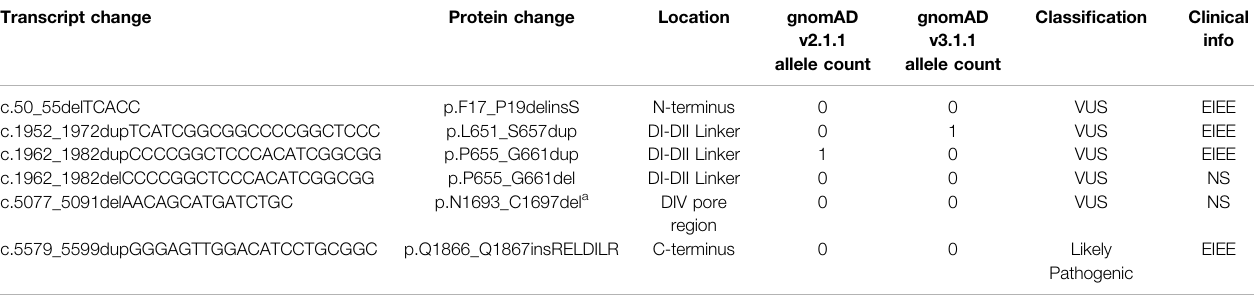
TABLE 1 | In-frame SCN8A variants observed in the ClinVar database.